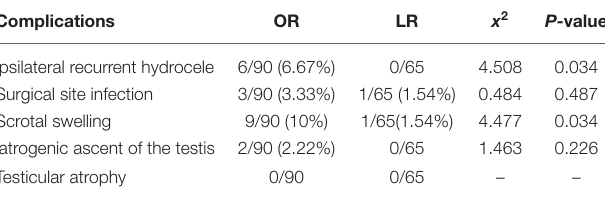
TABLE 3 | Postoperative complications in the OR and LR